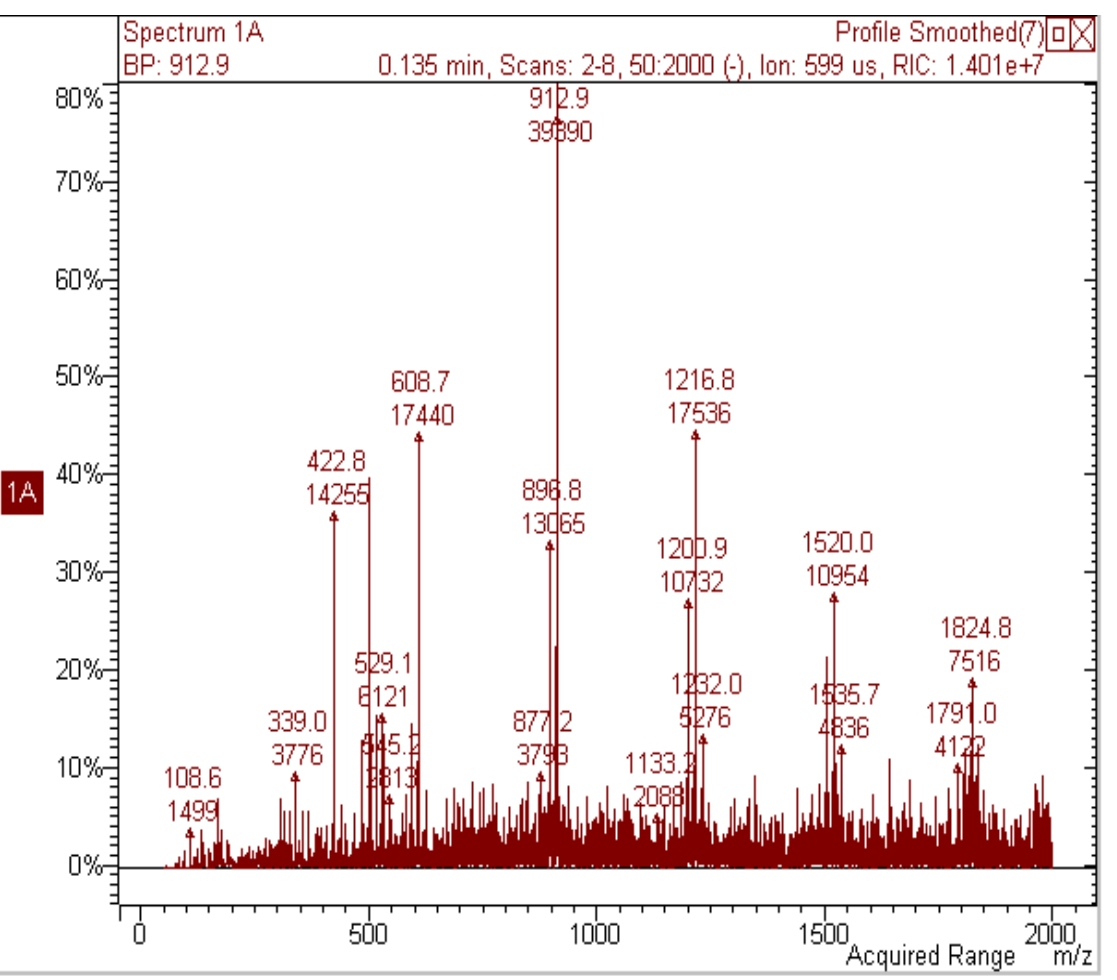
Figure 1. Mass spectrum of the methanol A. spectabilis bark